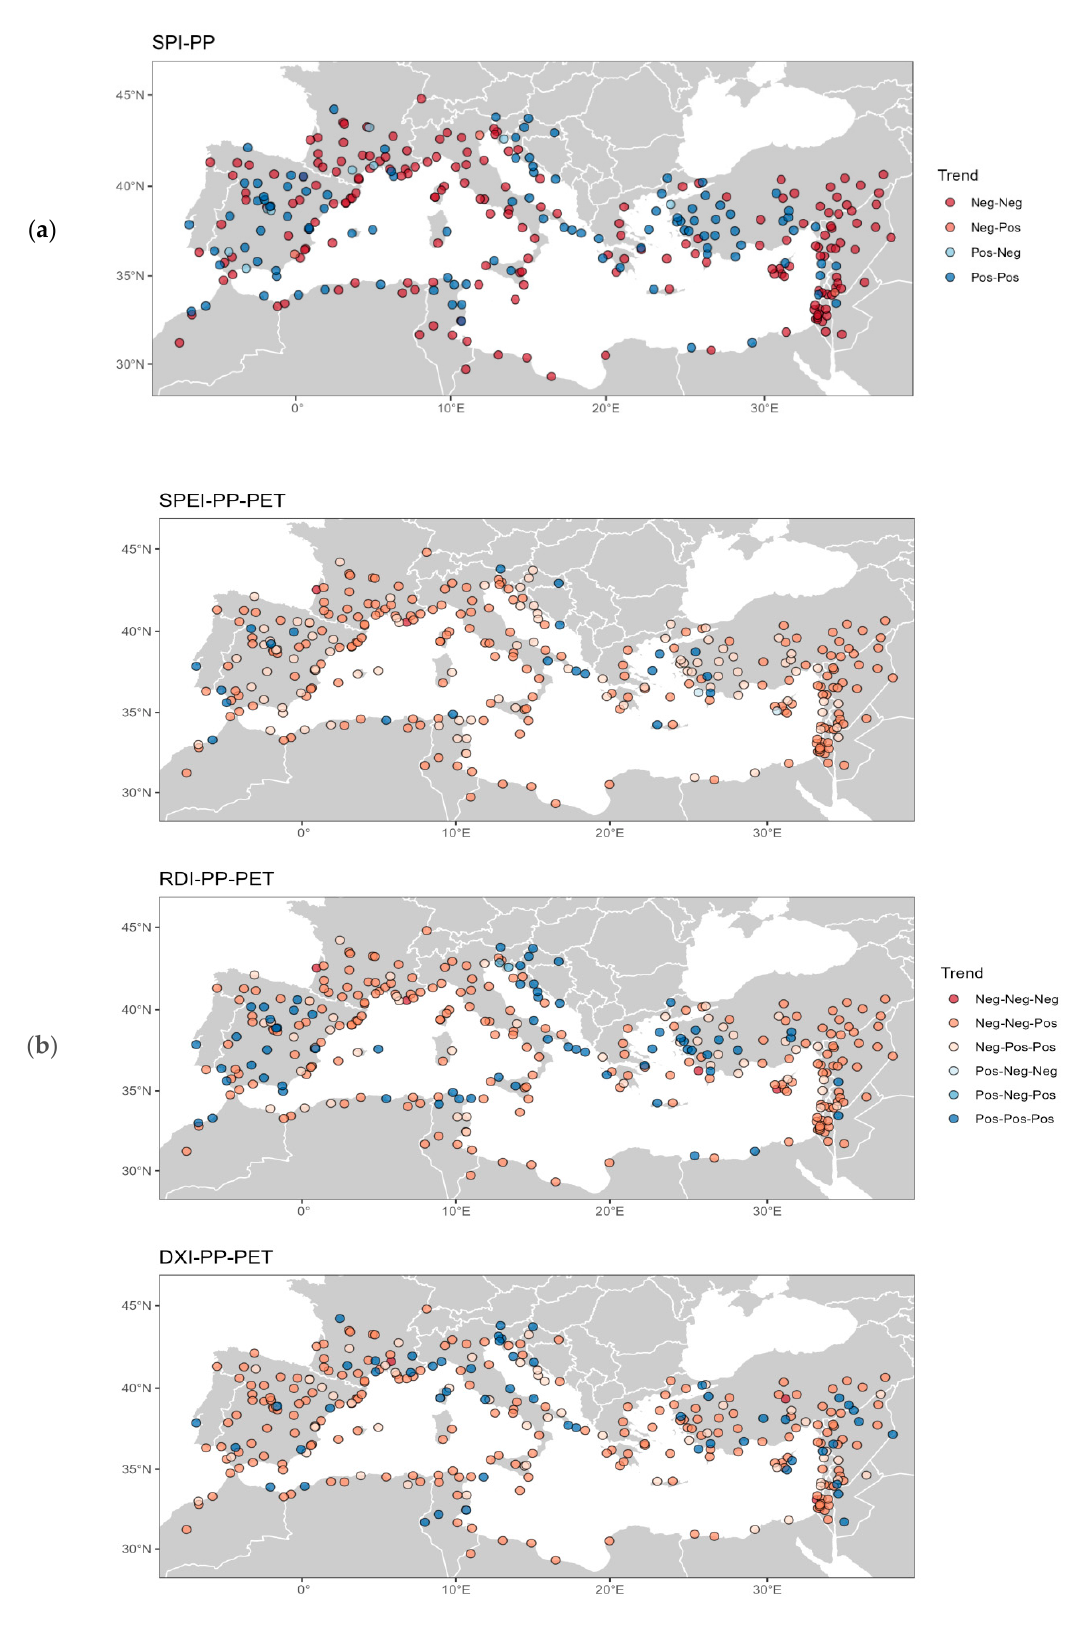
Figure 8. Drought tendencies from 1975–1996 to 1997–2019 according to the SPI-12 ( a ), SPEI-12, RDI-12 and DXI-12 ( b ) at a 12-month timescale and corresponding increases or decreases in precipitation amounts (PP) and evapotranspiration